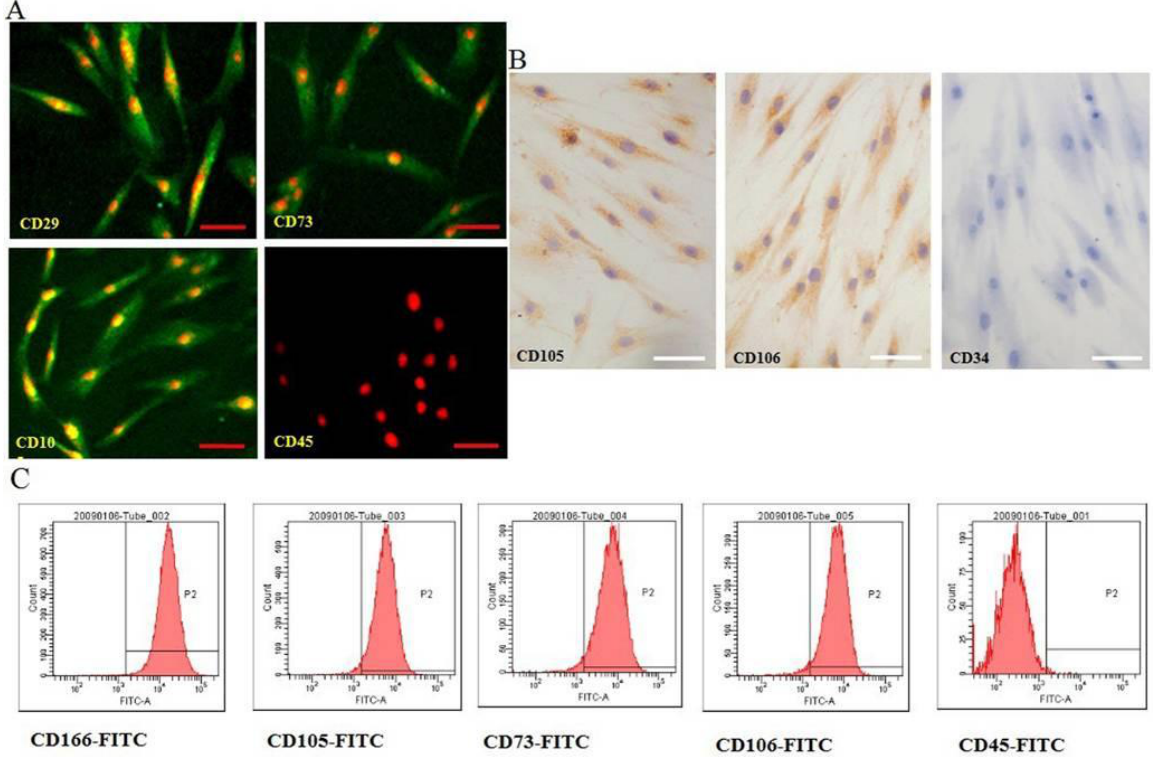
Figure 2. Isolated cells presented cell surface markers of the hMSCs. The expressions of indicated cell surface markers were determined on isolated hMSCs (passage 6) by immunofluorescence staining ( A ), immunocytochemical staining ( B ), and flow cytometric analysis ( C ). Images ( A ) were obtained using laser scanning confocal microscopy. Scale bar, 50 μm. Cells in the P2 gate ( C ) represented the positively stained population.